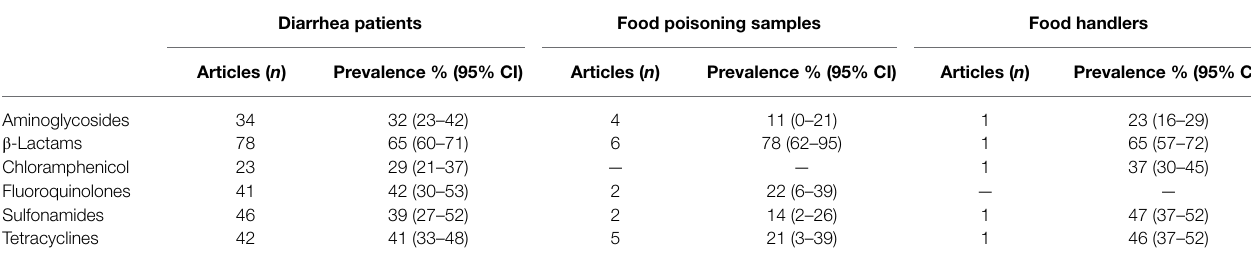
TABLE 4 | Subgroup analysis of antibiotic resistance by study population.